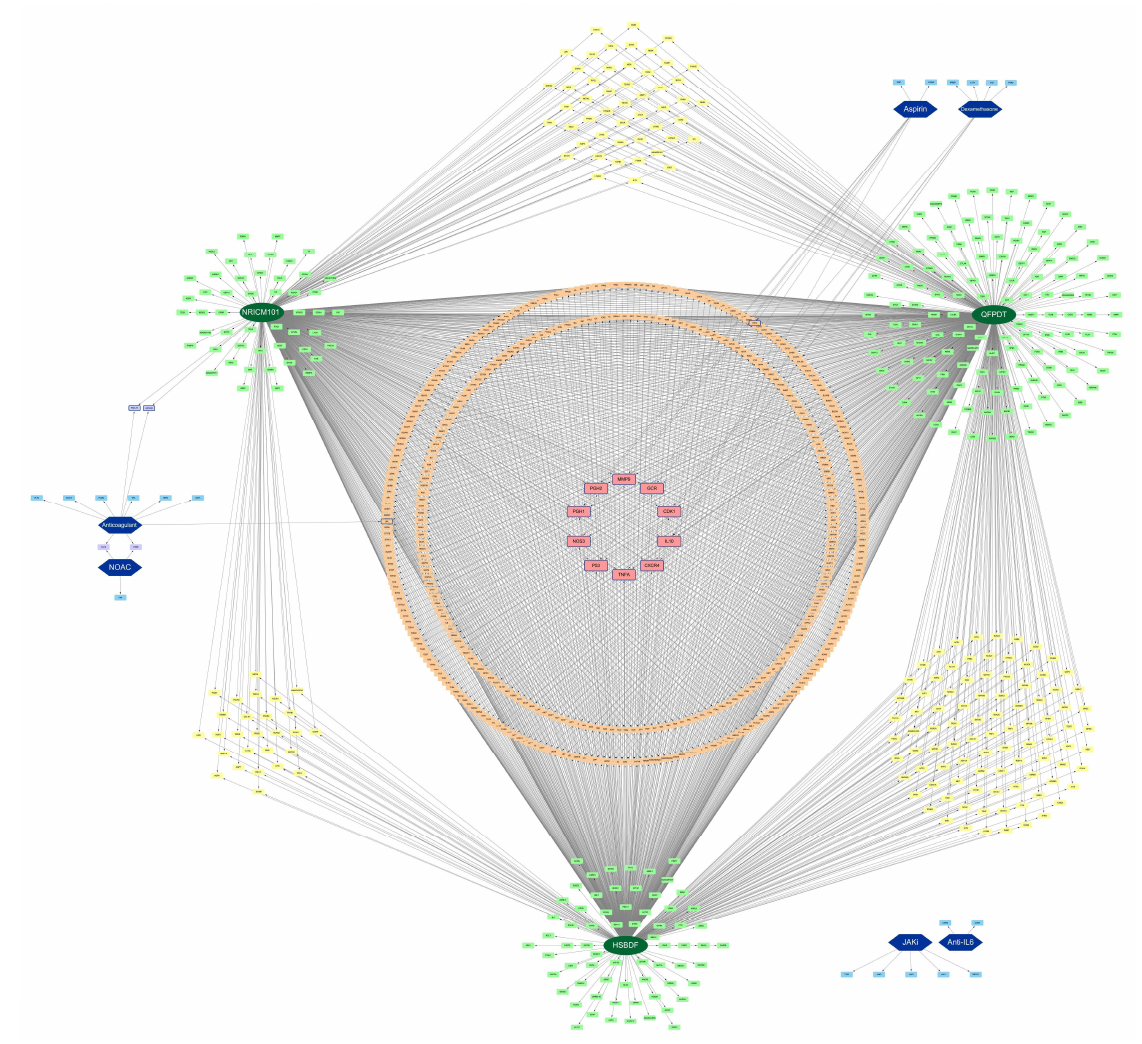
Figure 1. Target–drug interaction network of the 3 CHM formulas and 6 WM categories. Dark green oval labels indicate CHM, and dark blue hexagonal labels indicate WM. Light green labels indicate proteins that are only affected by one CHM, and light blue labels indicate proteins that are only affected by one WM. The target proteins in the yellow labels are affected by any two of the three CHM. The orange labels are affected by three